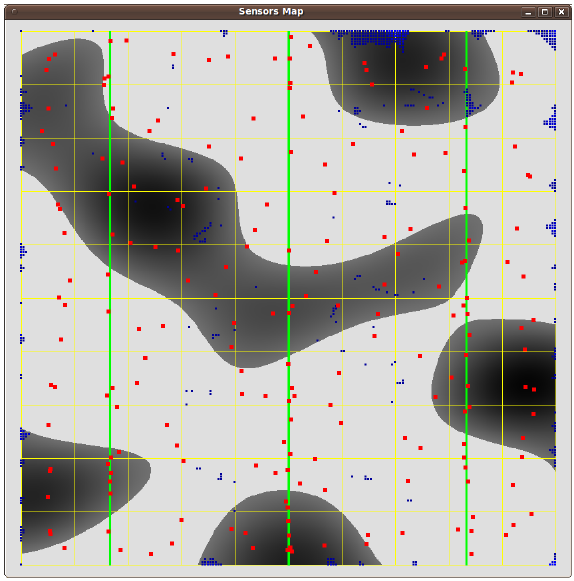
Figure 10. A sensor deployment for θ = 0 . 5